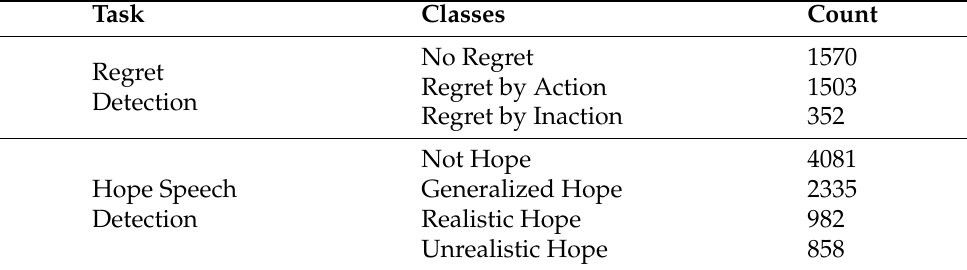
Table 3. Statistics of ReDDIT and PolyHope